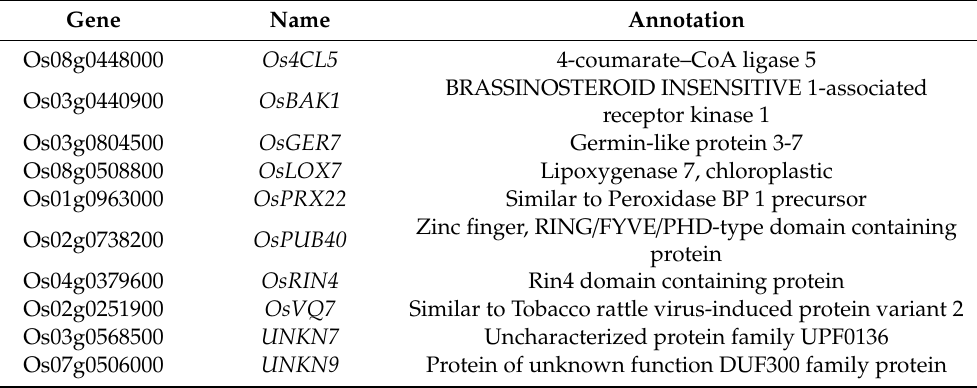
Figure 1. Relative expression levels of the 36 candidate genes in rice plants upon a four-hour treatment with NemaWater (NW; 133 nematode-equivalents/mL), lipopolysaccharides (LPS; 50 µg/mL) and N-acetylglucosamine heptamers (GlcNAc) 7 ; 2.5 µg/mL). Each cell color-codes the expression of one of the 36 genes (columns) upon treatment with one of three pathogen-associated molecular patterns (PAMPs; rows). The legend for this color-coding stands right. Yellow-boxed cells indicate significant upregulations (S.U.). Expression levels were determined by RT-qPCR and are expressed relative to mock treated plants. RT-qPCRs were performed with two technical replicates on three biologically independent replicates. Genes in bold and with an asterisk were selected for further analysis. Table 1. The ten candidate pattern-triggered immunity (PTI)-marker genes selected for further in vitro investigation, with their Rap-DB annotations [39].